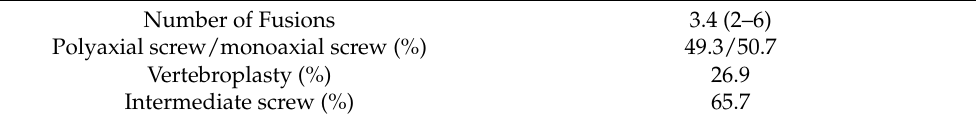
Table 2. Surgical content.